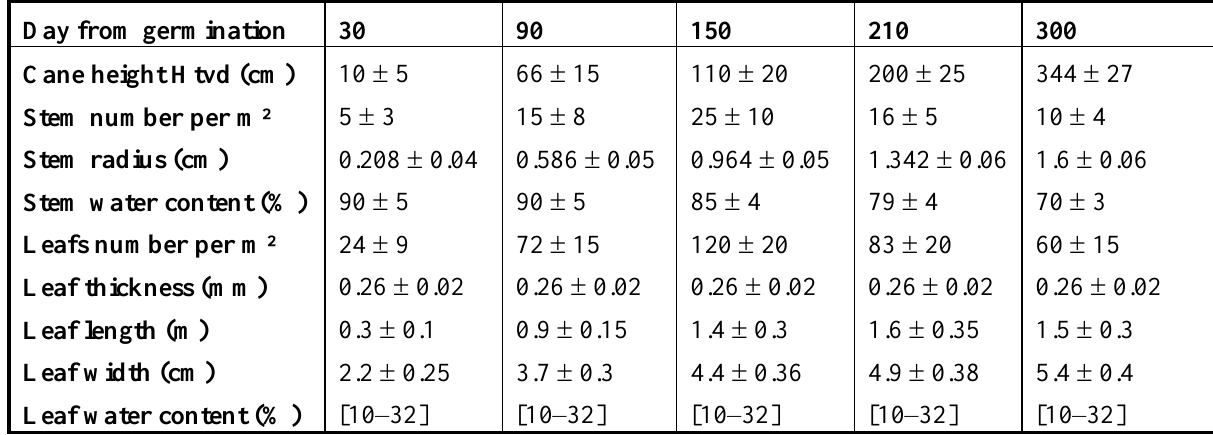
Table 3. Average values and standard deviation of sugarcane measured parameters. Htvd corresponds to the height of terminal visible